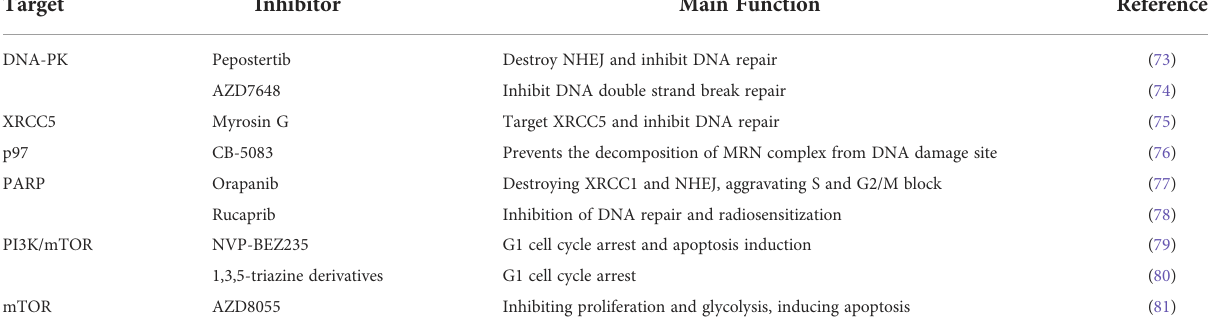
TABLE 2 List of small molecule inhibitors about DNA repair.